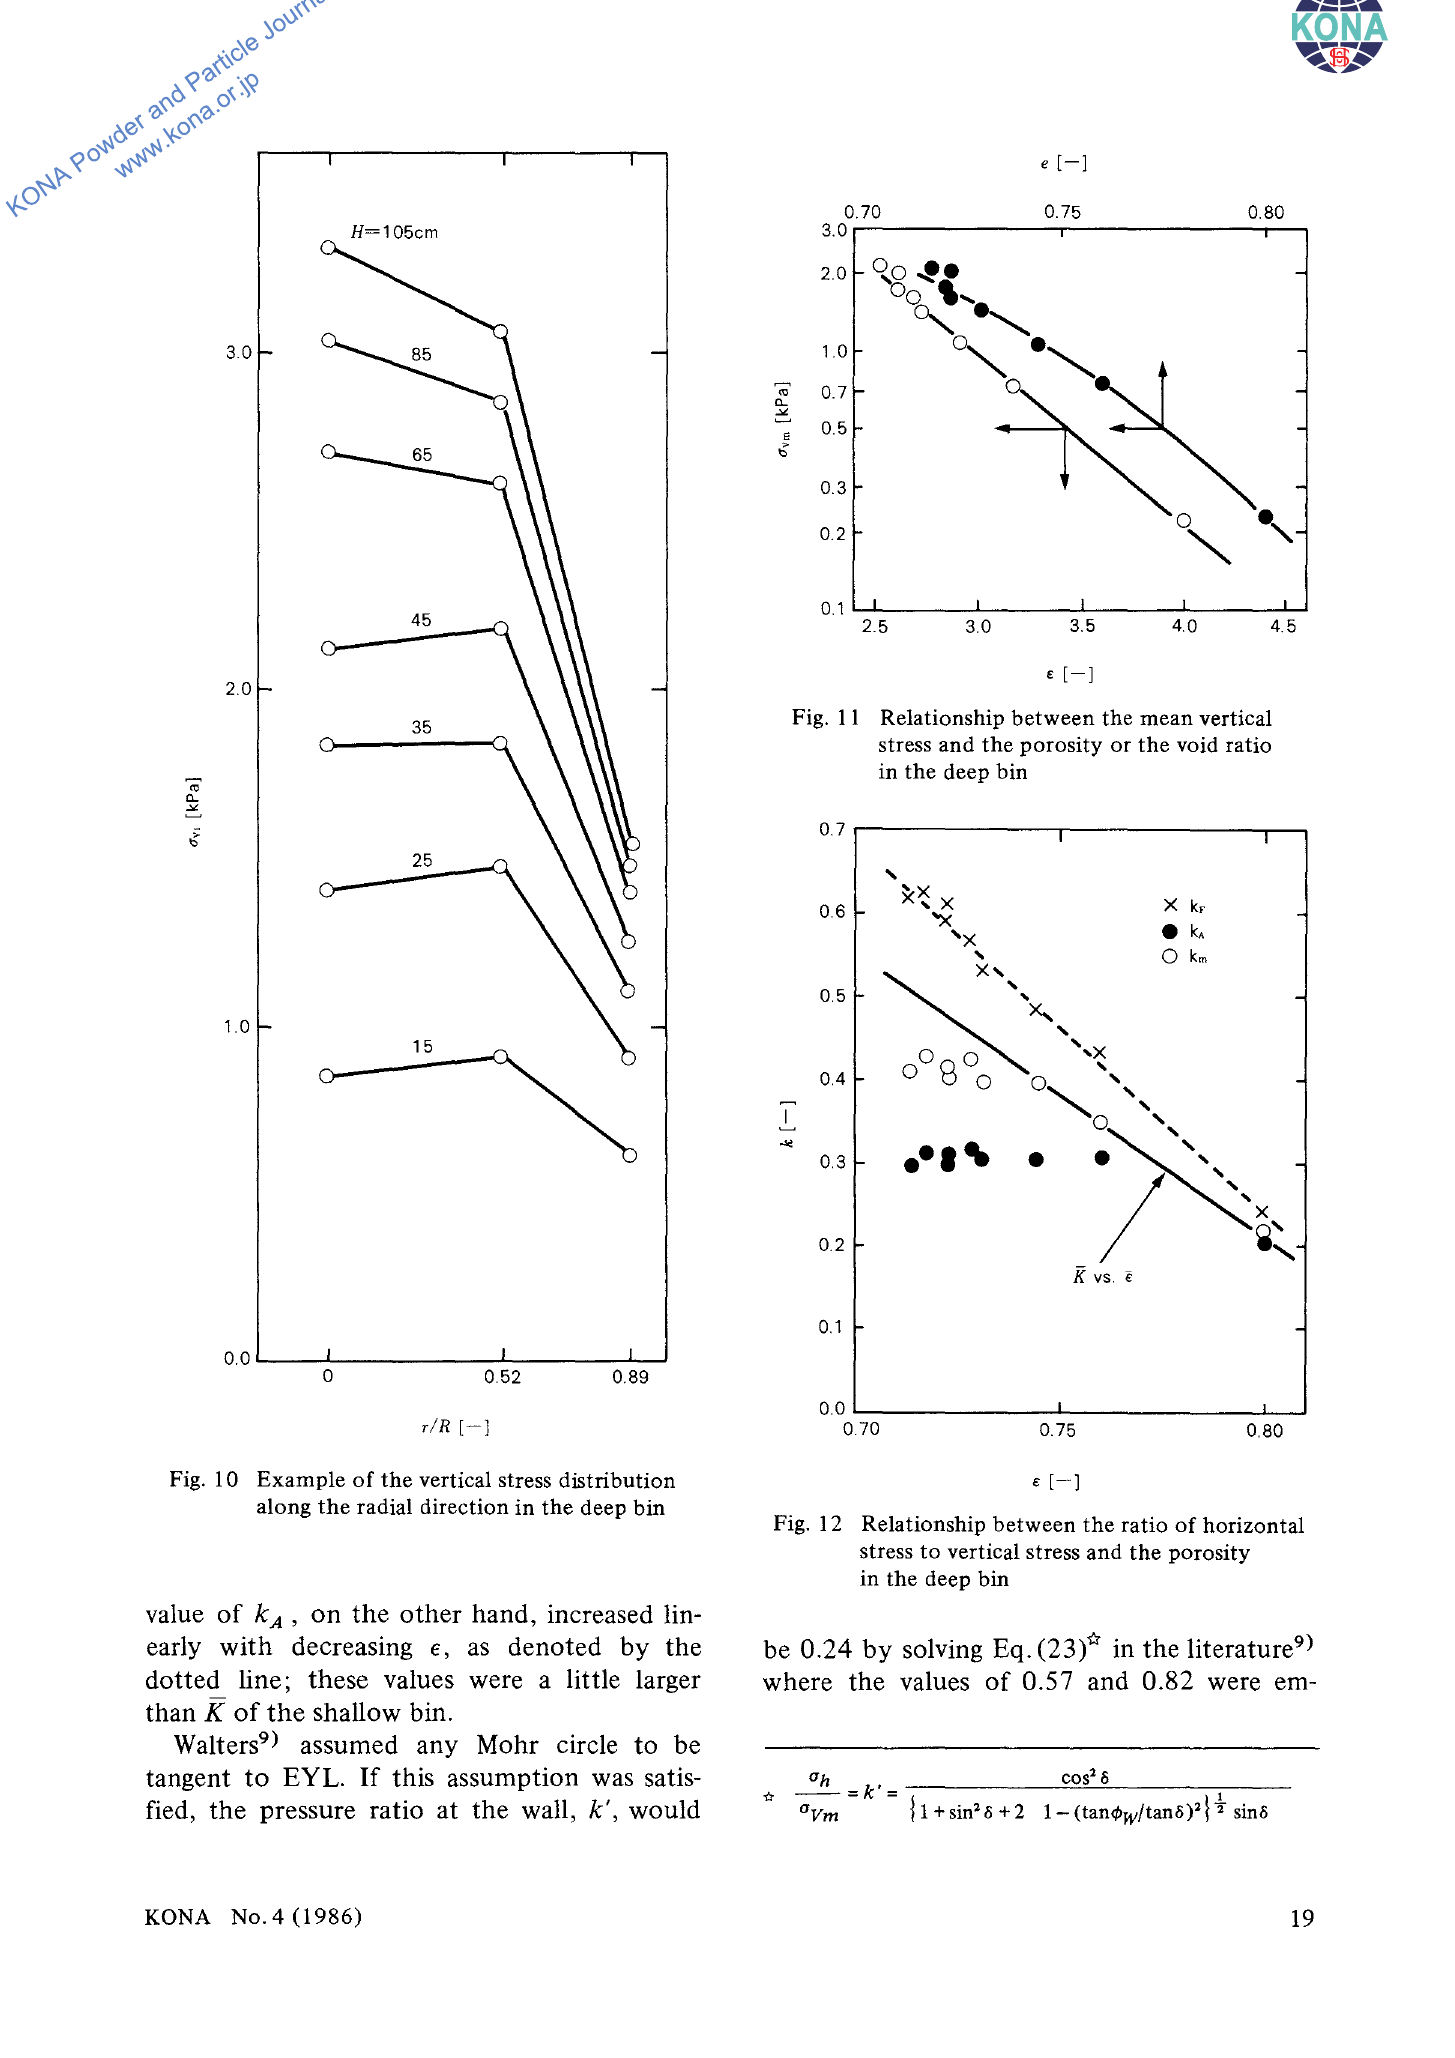
Fig. 10 Example of the vertical stress distribution along the radial direction in the deep bin